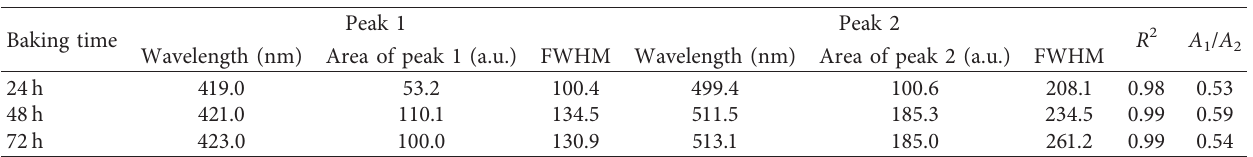
Table 2: The position, width, and area of peak 1 and peak 2 determined from Lorentz approximation of UV-Vis spectra of samples in baking times.